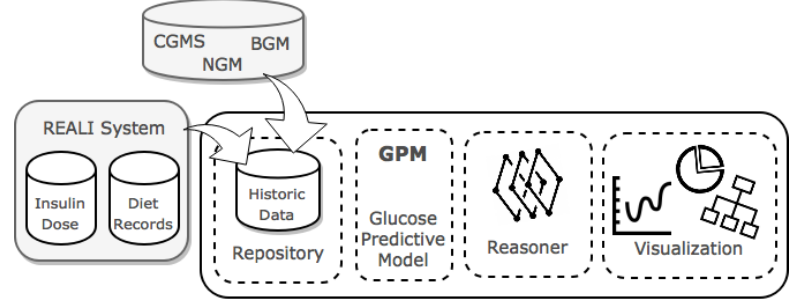
Figure 5. GLUMIS